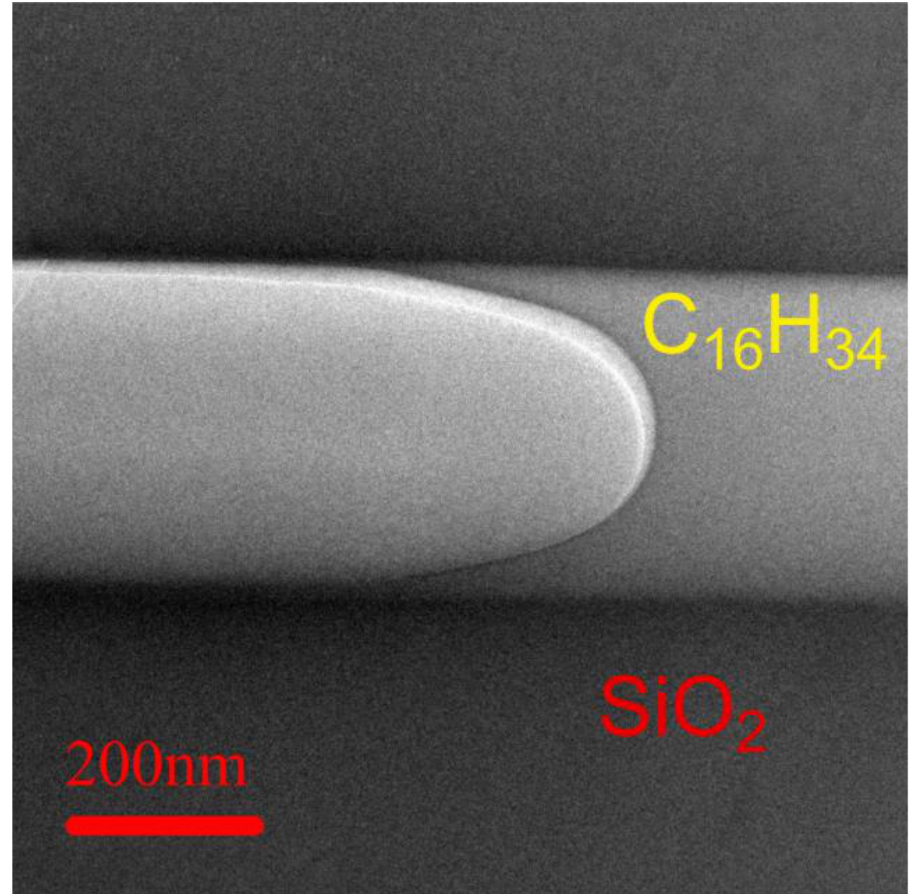
Figure 4. Sectional TEM image of samples in silica microtubules 0.4 μm in ID.